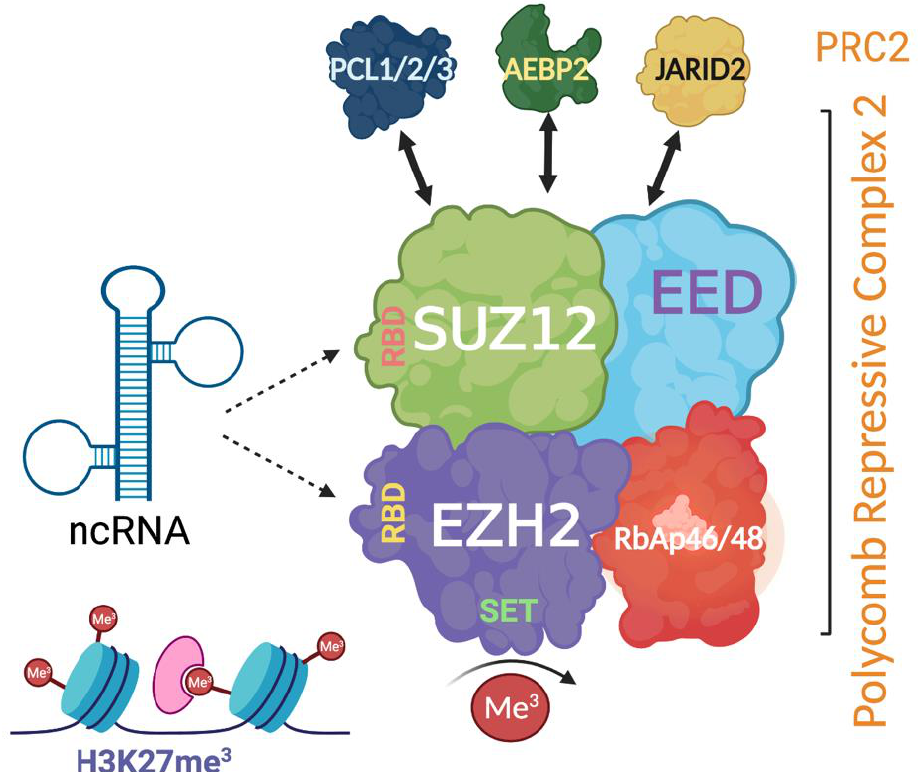
Figure 3. Schematic representation of the structure of polycomb repressive complex 2 (PRC2) and its interaction with non-coding RNA (ncRNA) via RNA binding sites. Created with BioRender.com. PRC2 has three major proteins including EZH2 (enhancer of zeste homolog 2), EED (embryonic ectoderm development), and SUZ12 (suppressor of zeste 12 homolog). EZH2 and SUZ12 have RNA-binding capacity. Accessory proteins such as JARID2 (jumonji and AT-rich interaction domain containing 2) associate and often co-purify with PRC2.